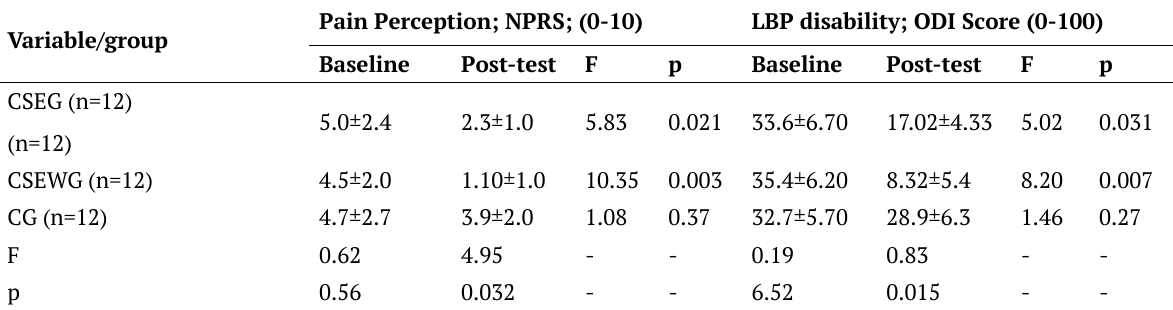
Table 4. The pain perception and LBP disability before and after the intervention (One-way ANOVA) Pain Perception; NPRS; Variable/group